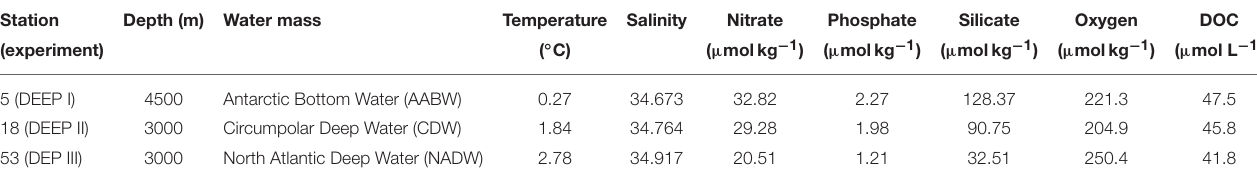
TABLE 3 | Physical and chemical signatures of the water masses used in each of the three DEEP experiments.